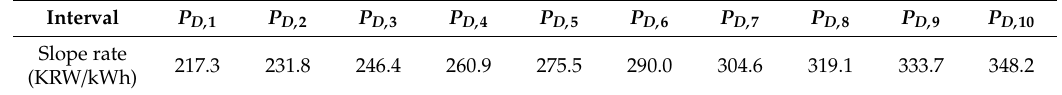
Table 1. Slope rate of each